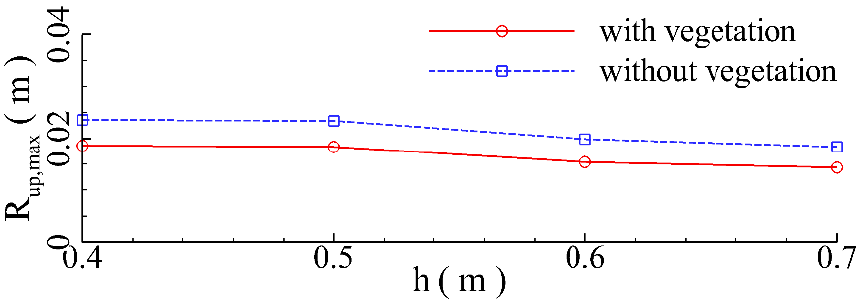
Figure 19. Dissipation rate of the wave energy under different water depths.